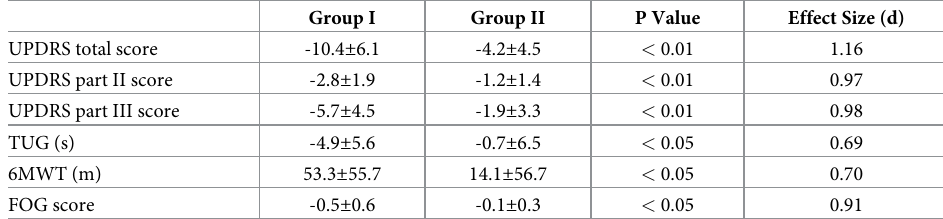
Table 3. Comparison between